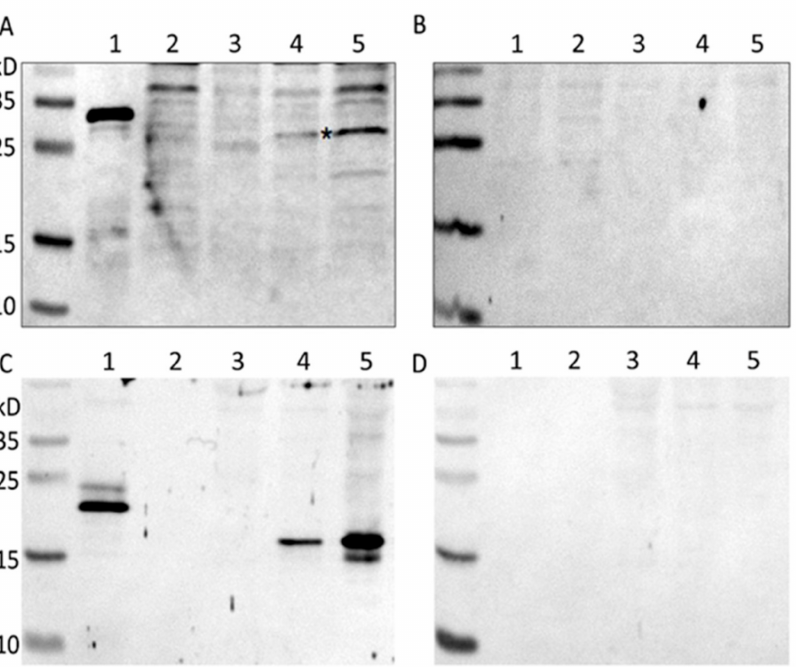
Figure 7. Western blot analysis of proteins expressed by rSPPV(RR-)VP1A-(TK-)OMP25 in LT cells. Protein gel loaded with 5 µ L of purified bacterially expressed protein VP1A ( A , B lane 1) and OMP25 ( C , D lane 1), and 10 µ L of lysate of cells: LT not infected ( A – D , lane 2), MDBK not